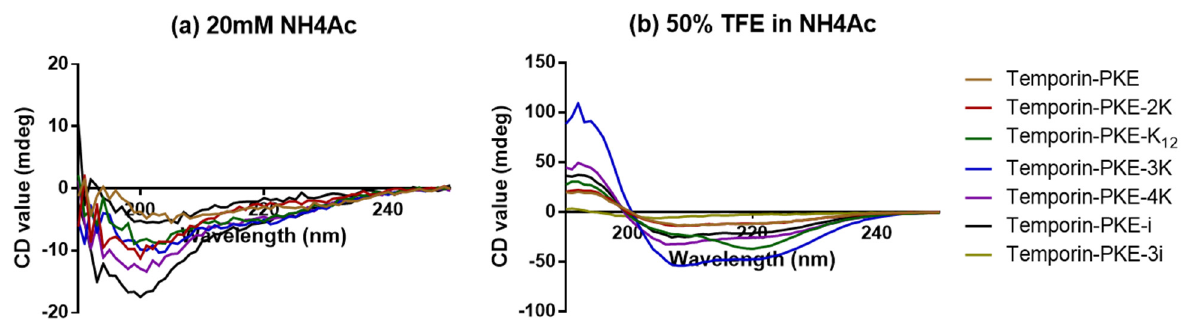
Figure 5. The CD spectra of temporin-PKE and its analogues in ( a ) aqueous solution (20 mM NH 4 Ac) and ( b ) membrane-mimicking solution [50% ( v / v ) trifluoroethanol (TFE) in NH 4 Ac].